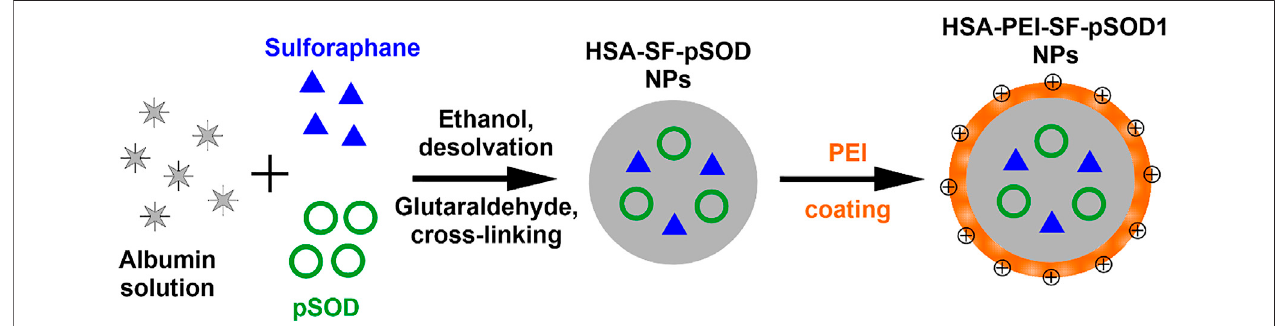
FIGURE 1 | Schematic representation of the basic steps in the fabrication of composite HSA-PEI-SF-pSOD1 nanoparticles.